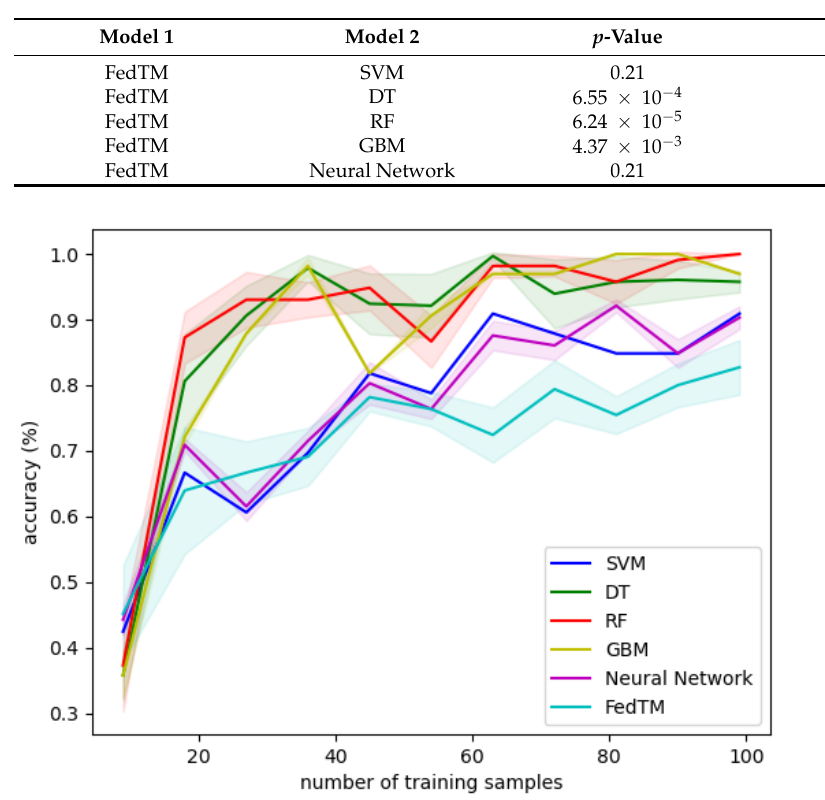
Figure 9. Classifiers’ accuracy according to the number of training